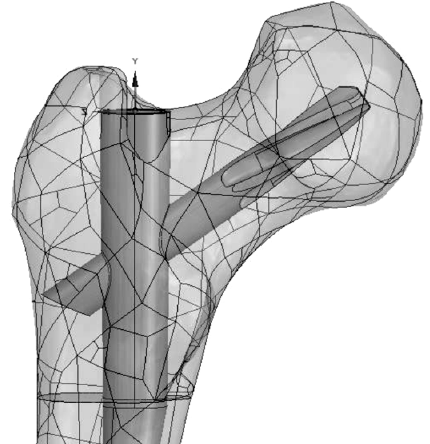
Figure 4. The 3D model of the femoral CM nail inside the femoral bone.